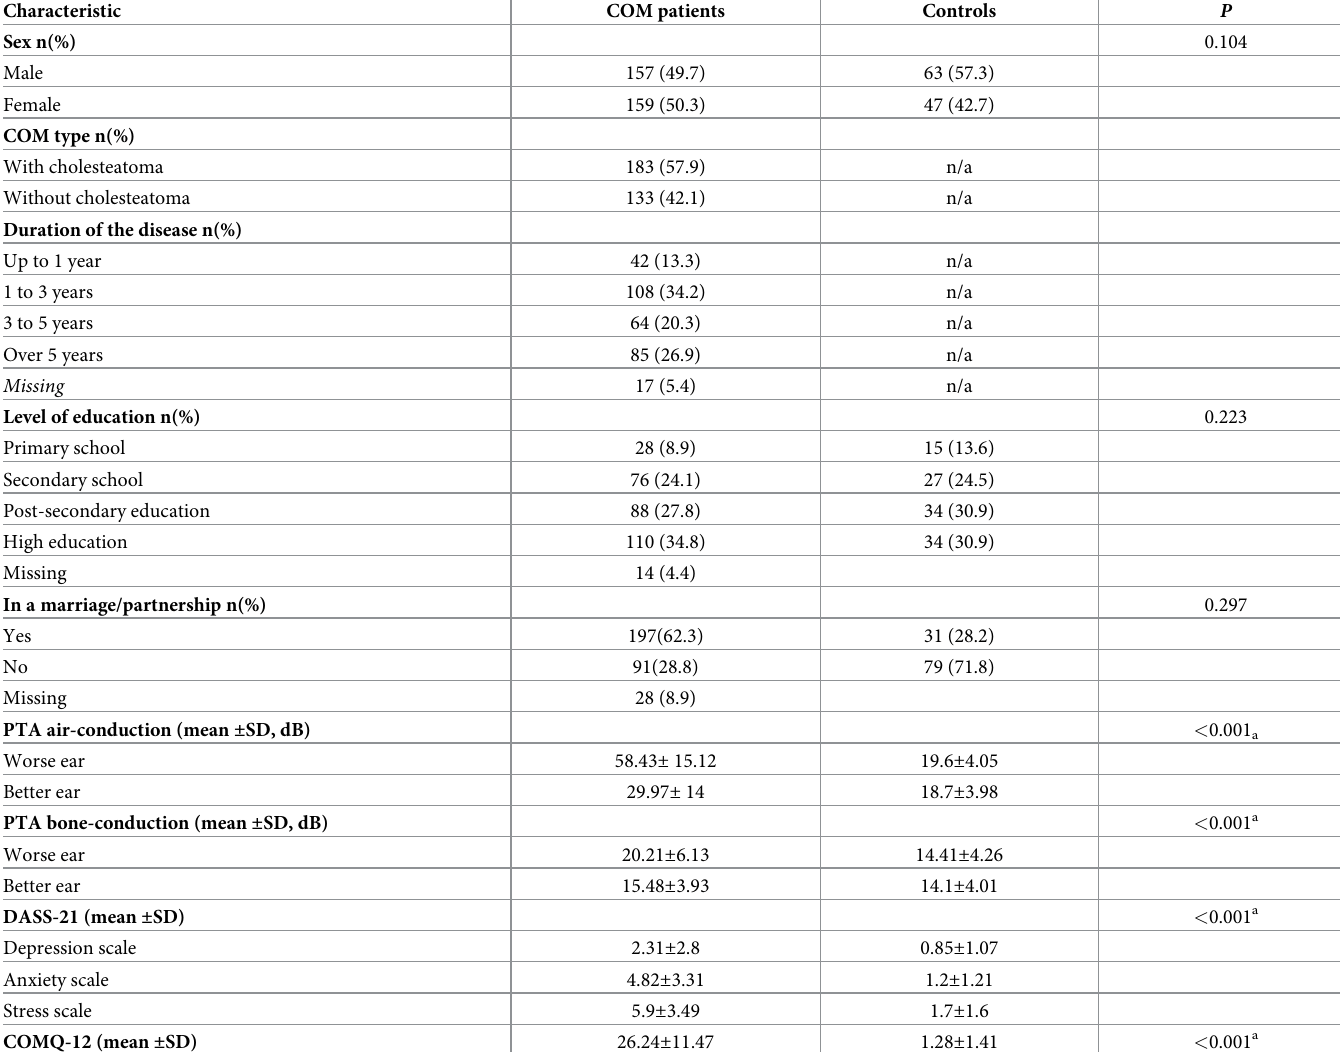
Table 1. Characteristics of the patients with COM and control group volunteers included in the